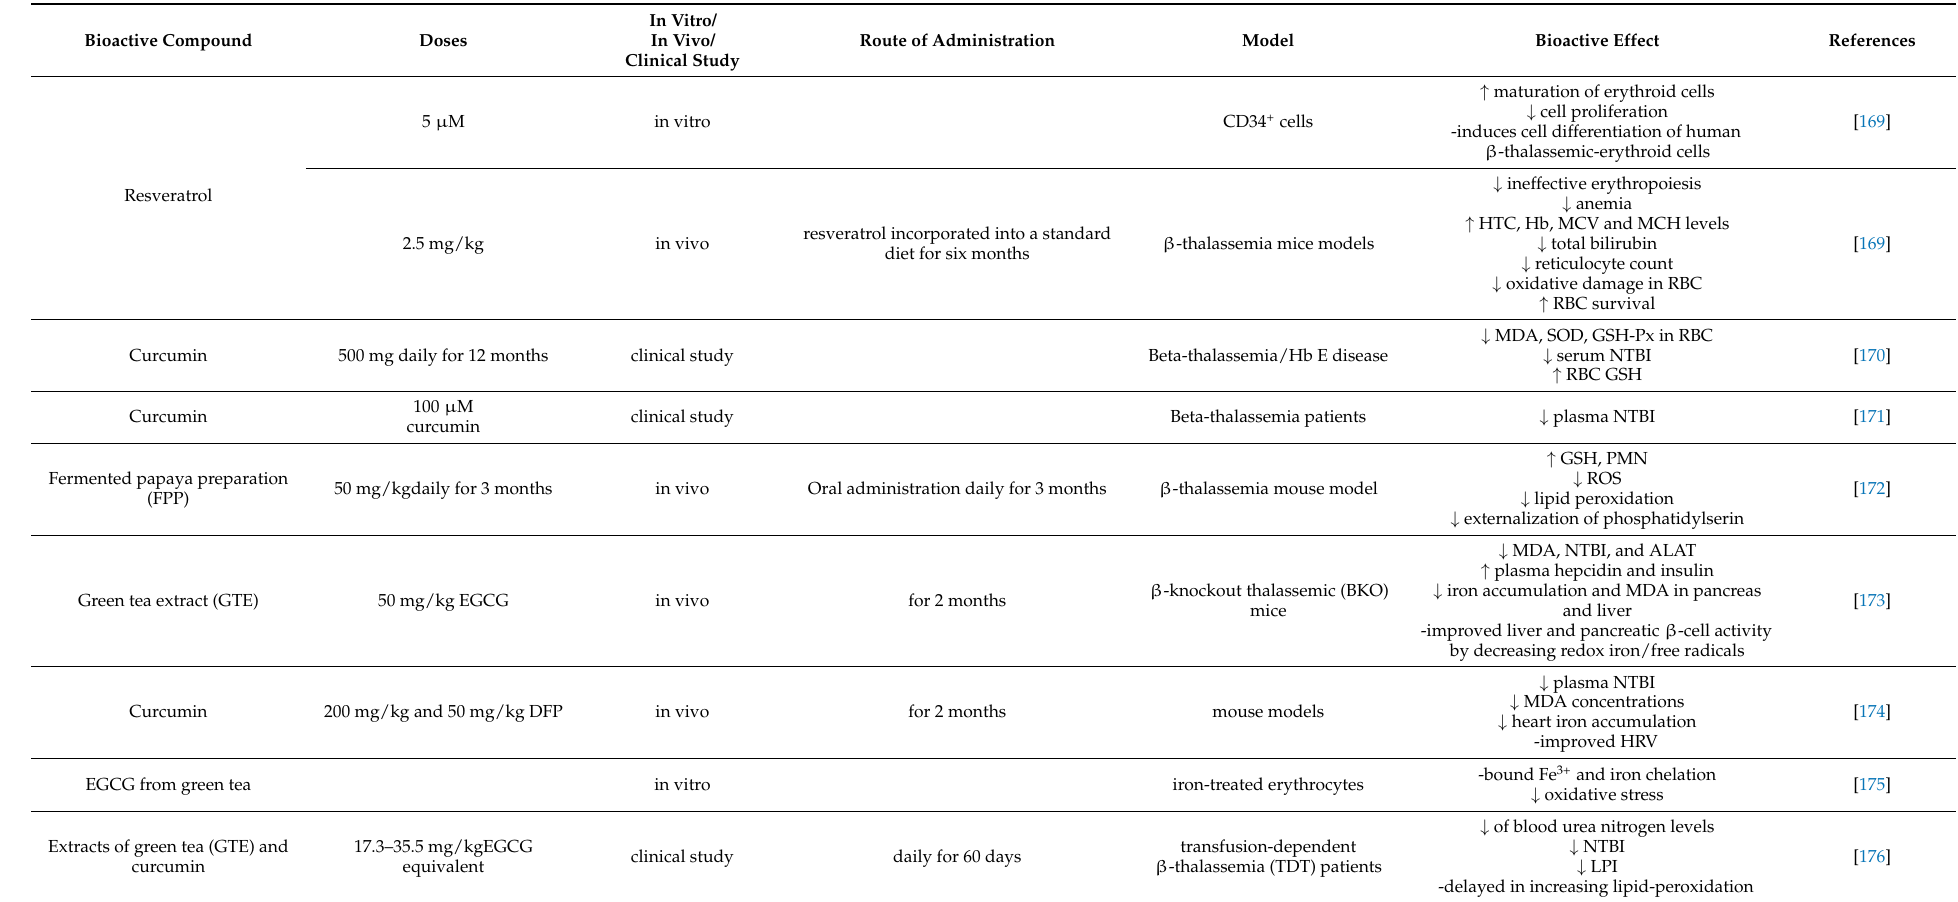
Table 4. Pharmacological effects of natural antioxidants in β -thalassemia